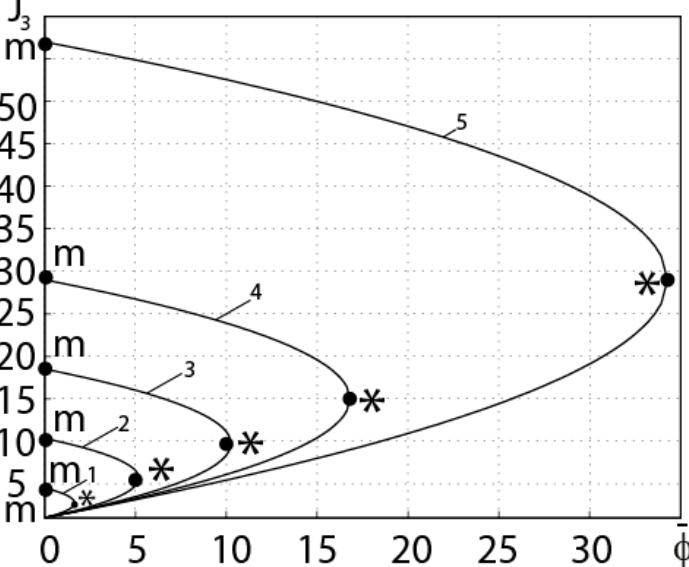
shown in Figure 4.